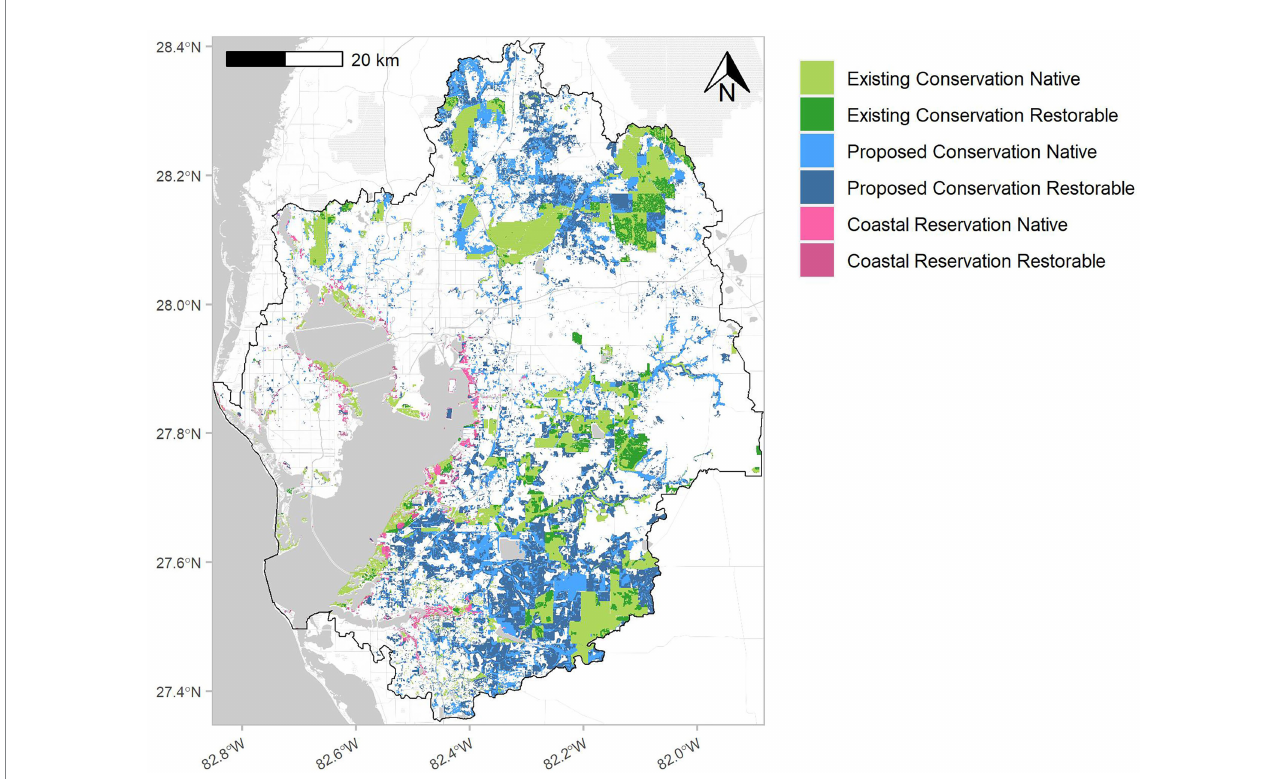
FIGURE 5 Opportunity areas for habitat restoration in the Tampa Bay watershed. Green indicates existing conservation, blue indicates proposed conservation, and pink indicates reservation opportunities. Each category is also grouped into native and restorable habitats. The outline is the Tampa Bay